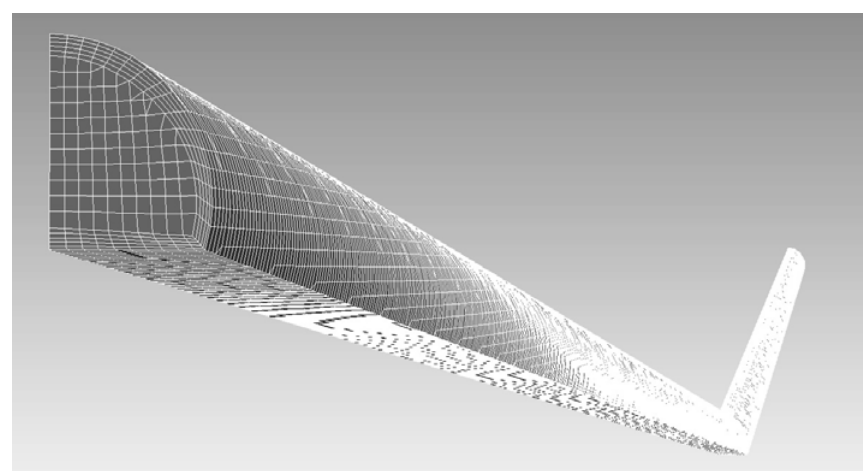
Figure 2. Numerical mesh of the tunnel model.